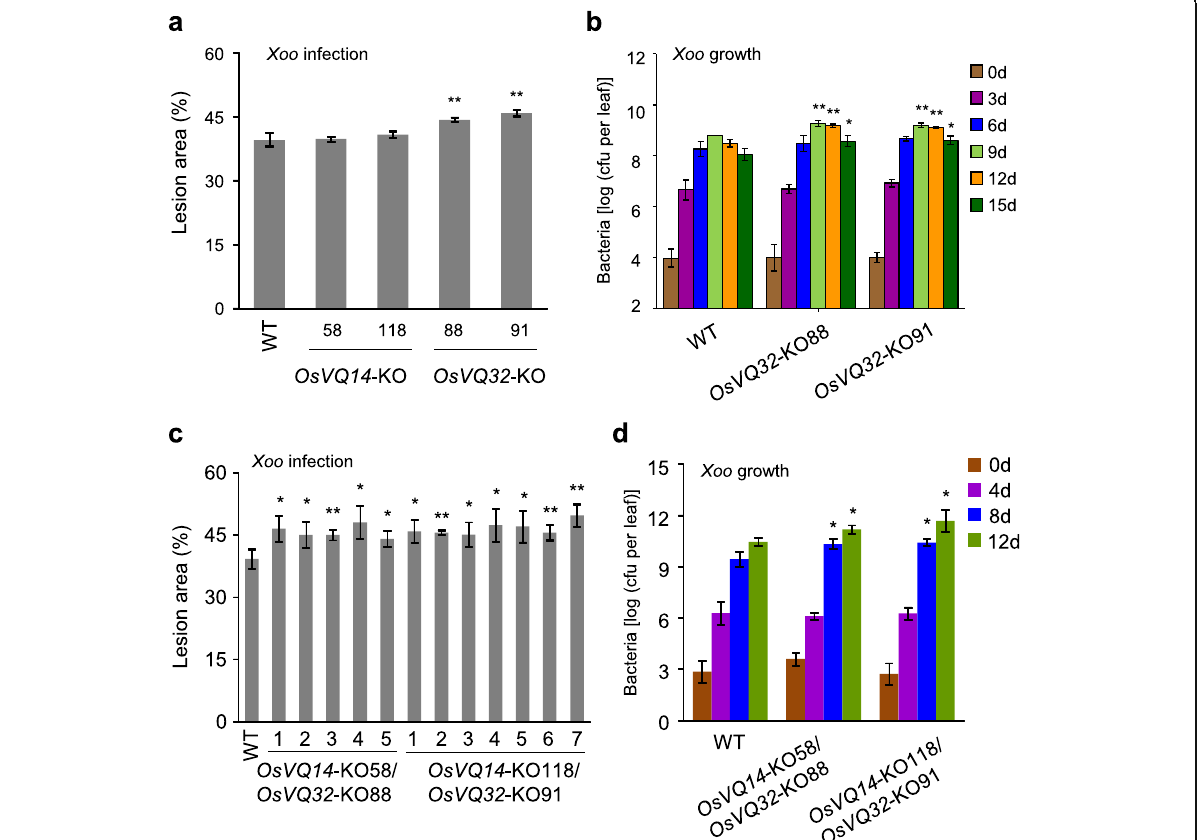
Fig. 2 Knocking out OsVQ32 reduced rice resistance to Xoo . The asterisks “ ** ” or “ * ” indicate a significant difference between transgenic plants and wild type (WT; Zhonghua 11) at P < 0.01 or P < 0.05, respectively. a Analysis of the response of OsVQ14 -KO and OsVQ32 -KO plants to Xoo inoculation. Bars represent mean (3 to 5 plants, with each plant having 3 leaves for lesion area) ± standard deviation (SD). b Analysis of the Xoo growth in leaves of OsVQ32 -KO plants. Bars represent mean (3 leaves from 3 positive plants) ± SD. The significant difference was detected between transgenic plants and WT with the same treatment. cfu, colony-forming unit. c Analysis of the response of OsVQ14 -KO/ OsVQ32 -KO double mutants to Xoo inoculation. Bars represent mean (3 leaves from one plant for lesion area) ± standard deviation (SD). d Analysis of the Xoo growth in leaves of OsVQ14 -KO/ OsVQ32 -KO double mutants. Bars represent mean (3 leaves from 3 positive plants) ± SD. The significant difference was detected between transgenic plants and WT with the same treatment. cfu, colony-forming